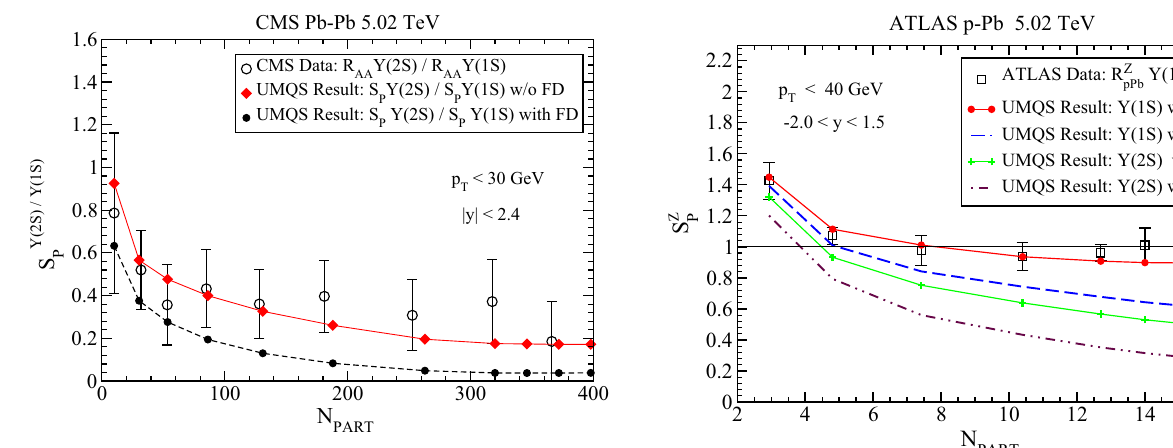
Fig. 16 The centrality variation of our calculated yield ratio of ϒ( 2 S ) to ϒ( 1 S ) is compared with the measured double ratio as a function of centrality in Pb–Pb collisions obtained from CMS experiment at √ s NN = 5 . 02 TeV [91]